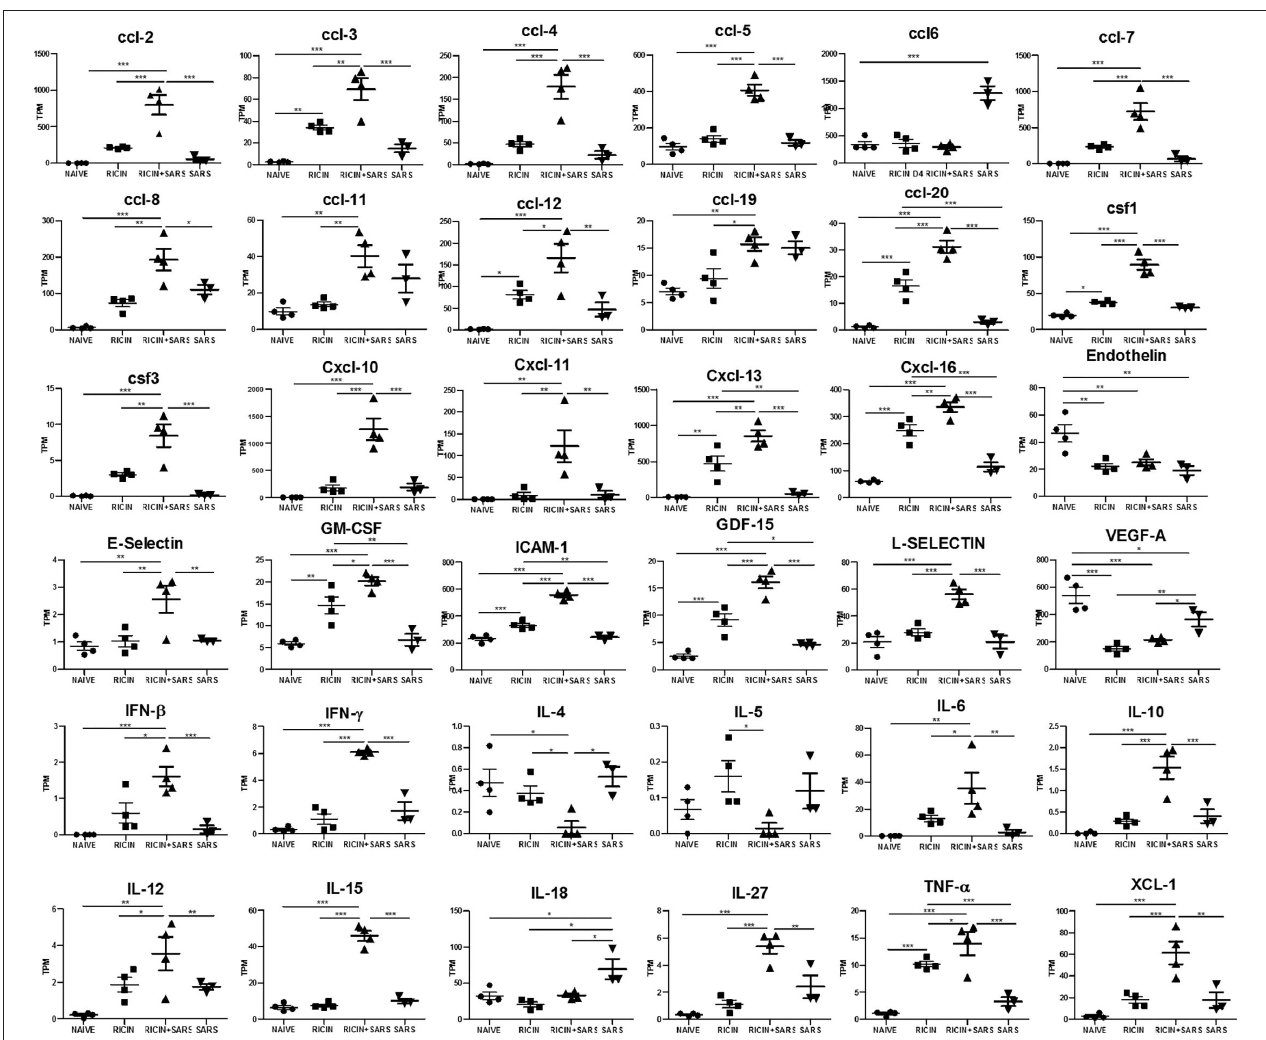
FIGURE 8 | LDR-SC2 significant cytokine and chemokine gene expression in lungs compared to naïve or LDR or or SC2 mice. Normalized gene expressed levels (transcripts per million, TPM) of 23 indicated cytokines and chemokines determined from RNAseq data. Data are presented as average ± SEM ( n = 3–4 per group) analyzed using unpaired t- test. * p < 0.05, ** p < 0.01, *** p <